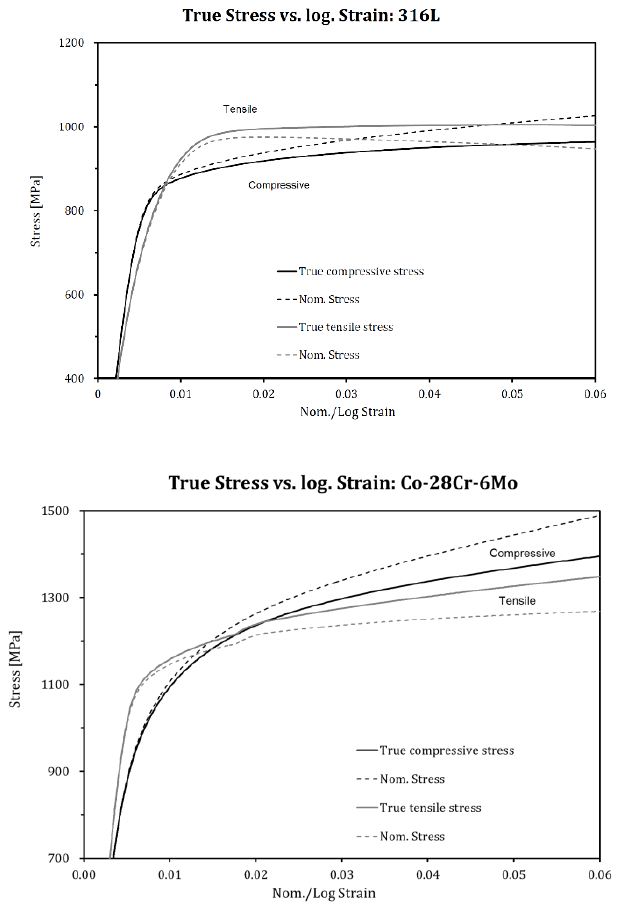
Figure 4. Asymmetry in steel 316L ( top ) and Co-28Cr-6Mo ( bottom ).